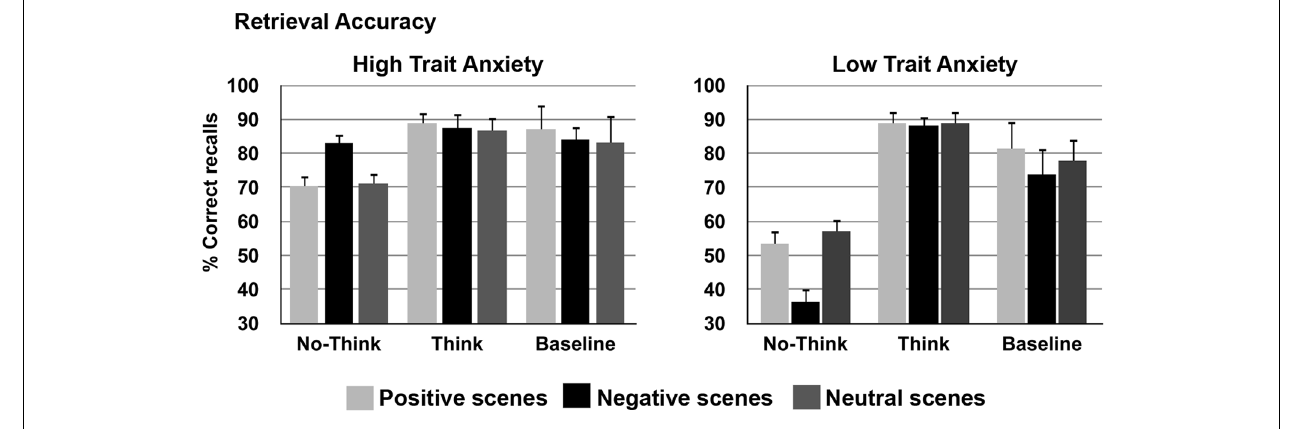
FIGURE 2 | Overall mean correct recall percentages of emotional scenes (positive, negative, and neutral) for baseline, think and no-think conditions, shown on the left for the high trait anxiety group and on the right for the low trait anxiety